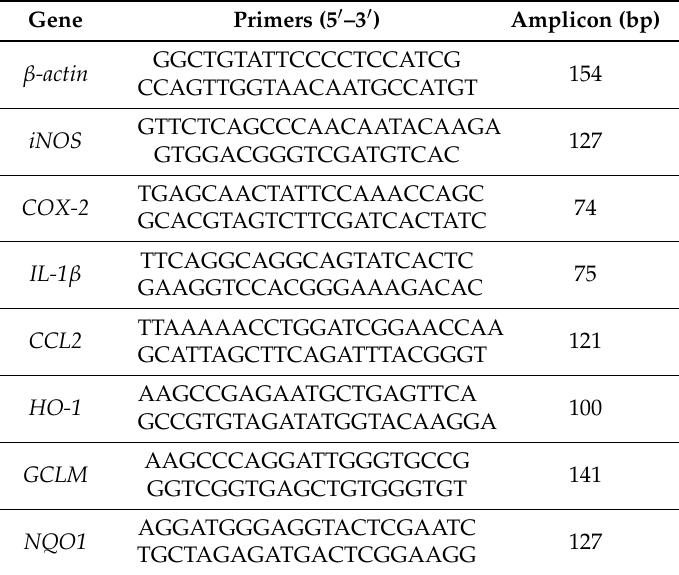
Table 2. Primer pairs used in